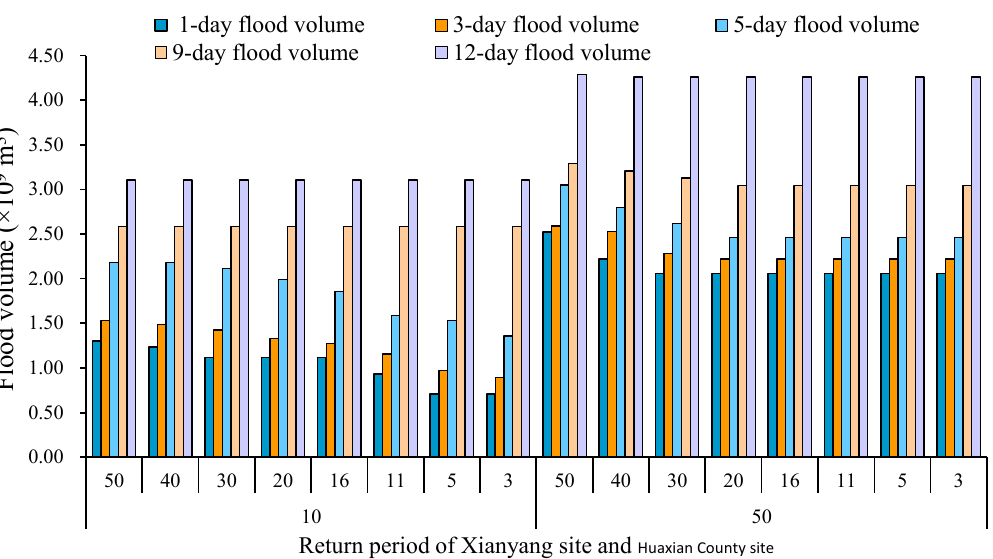
Figure 14. Flood volume of Zhangjiashan under different return periods of Xianyang and Huaxian County. Table 4. Flood peak volume of Zhangjiashan under different return periods of Xianyang and Huaxian County.